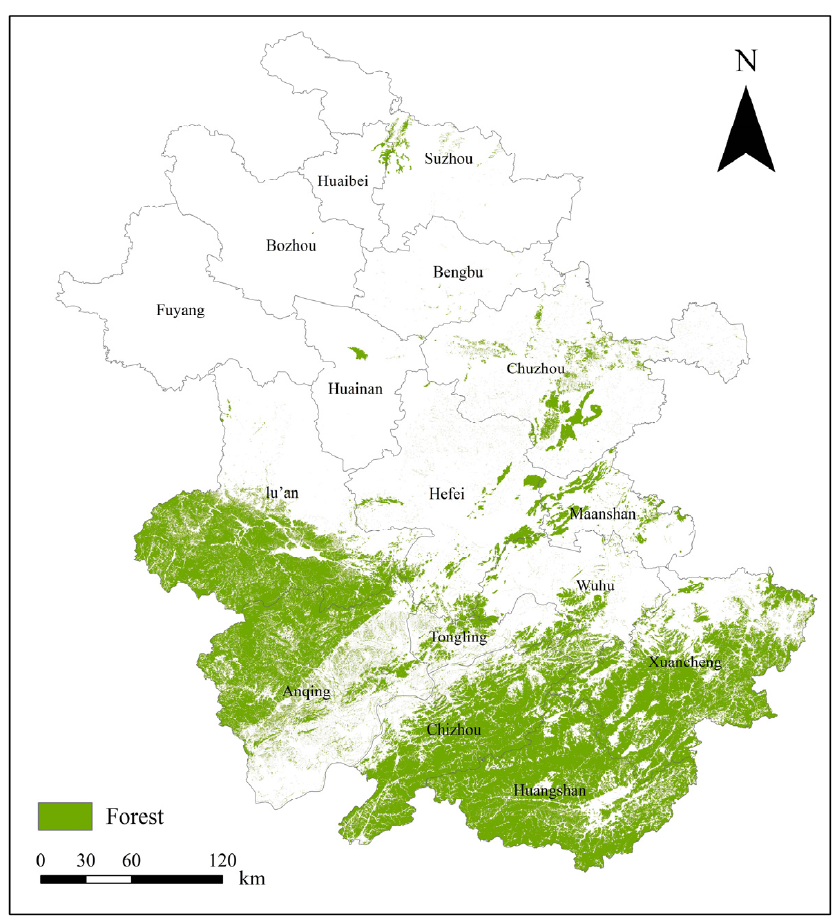
Figure 3. GlobeLand30 woodland range map of Anhui Province in 2020.